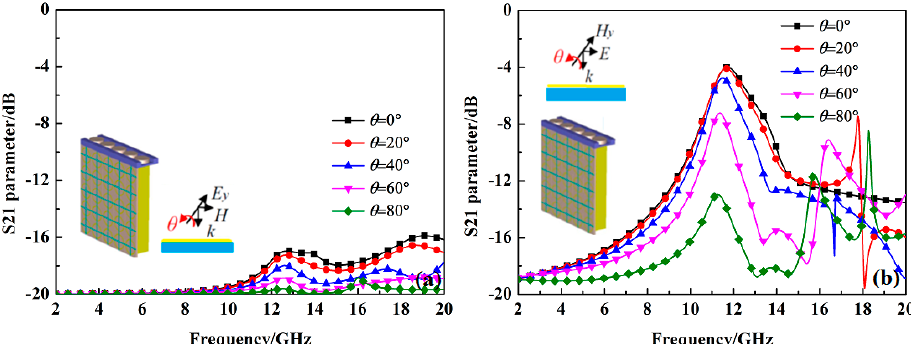
Figure 9. The transmission coefficient at different incident angles when the rotatable metal plate is perpendicular to the rest of the layers, ( a ) TE mode, ( b ) TM mode.